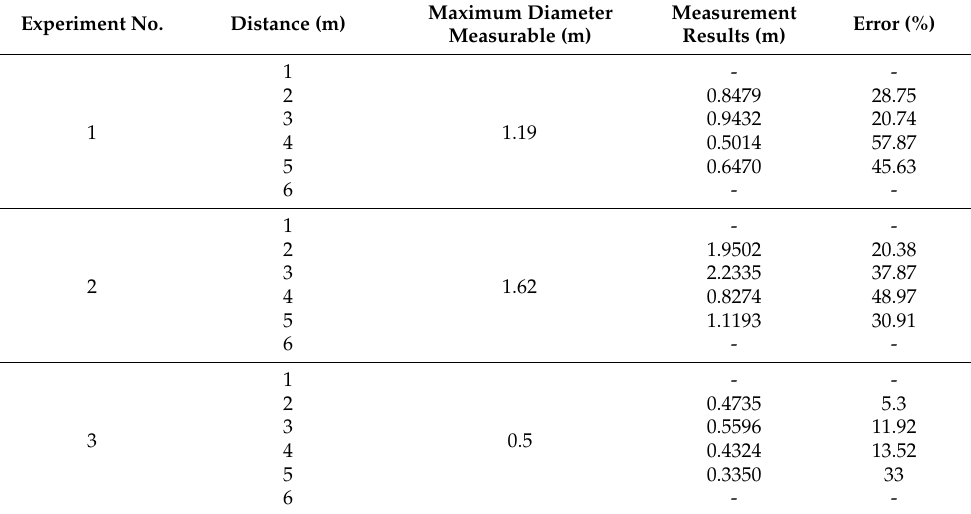
Table 5. Experimental results of negative obstacle measurement in non-structural environments. Experiment No. Distance (m)